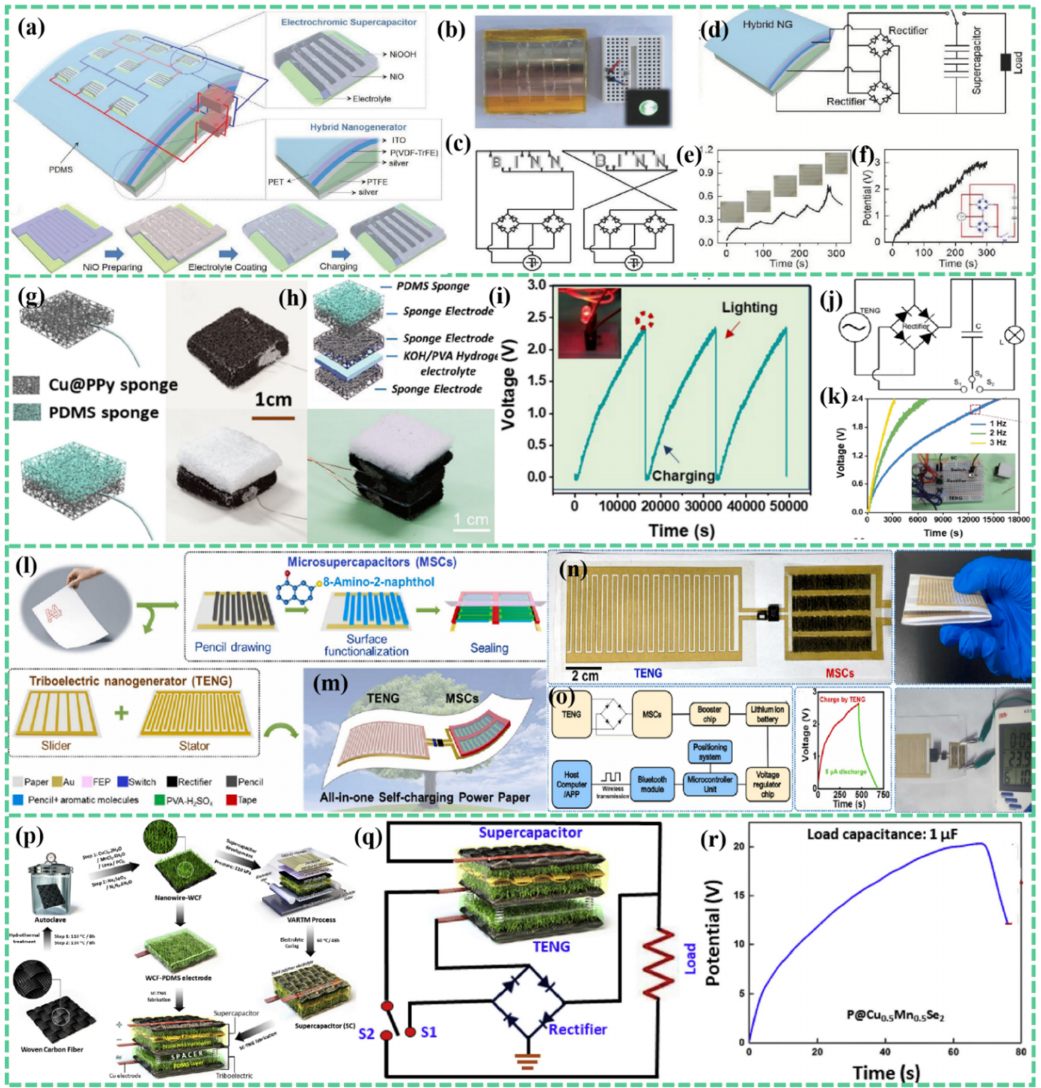
Figure 6. TENG-UPS with film and sponge structure. ( a – f ) Hybrid piezo/triboelectric-driven self- charging electrochromic supercapacitor power package. ( a ) Schematic illustration of the self-charging power package. ( b ) The self-charging power pack serves as the power supply for the LED